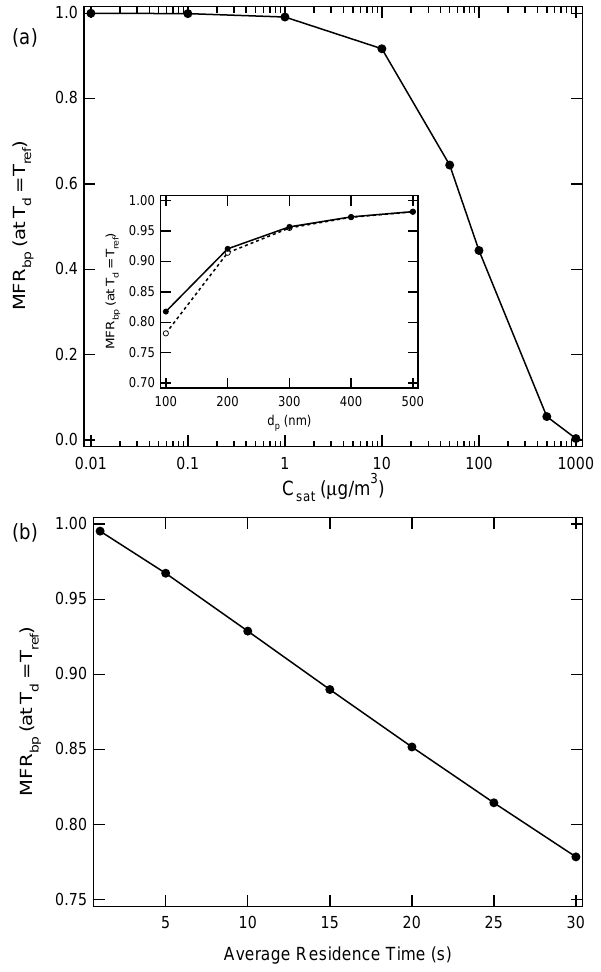
Fig. 4. (a) Calculated mass fraction remaining (MFR bp ) at T d = T ref (i.e. no heating) for single-component particles shown as a function of C sat ( d p =200nm, C OA =50µg/m 3 ) using the adsorbent denuder boundary condition (Case 1). (inset) Calculated MFR bp at T d = T ref as a function of particle diameter for C sat =10µg/m 3 at two different aerosol mass loadings, 5µg/m 3 ( • ) and 150µg/m 3 ( ◦ ). (b) Calculated MFR bp at T d = T ref as a function of the residence time in the denuder ( C sat =10µg/m 3 , d p =200nm and C OA =150µg/m 3 ) .